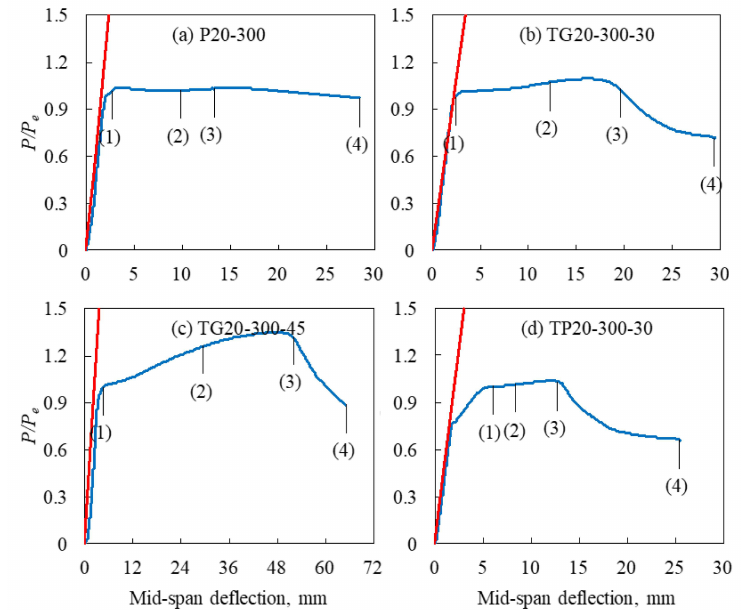
Figure 5. Load versus mid-span deflection curves of beam specimens #1–4 (red line extends the